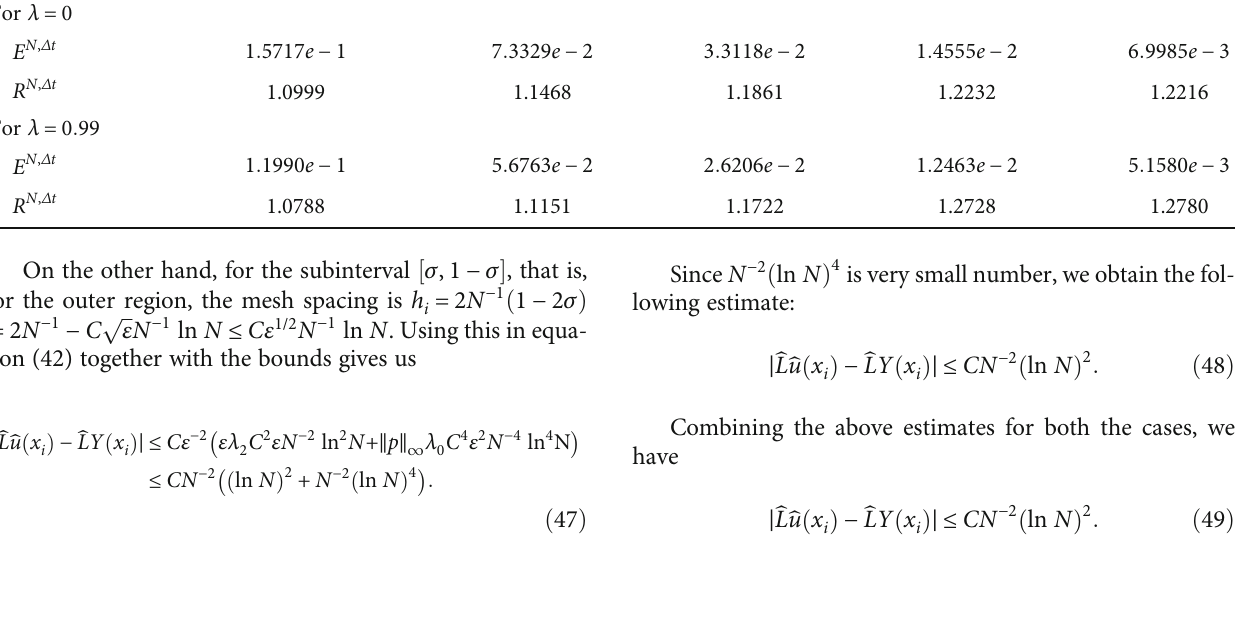
Table 2: The maximum point-wise errors E N , Δ t